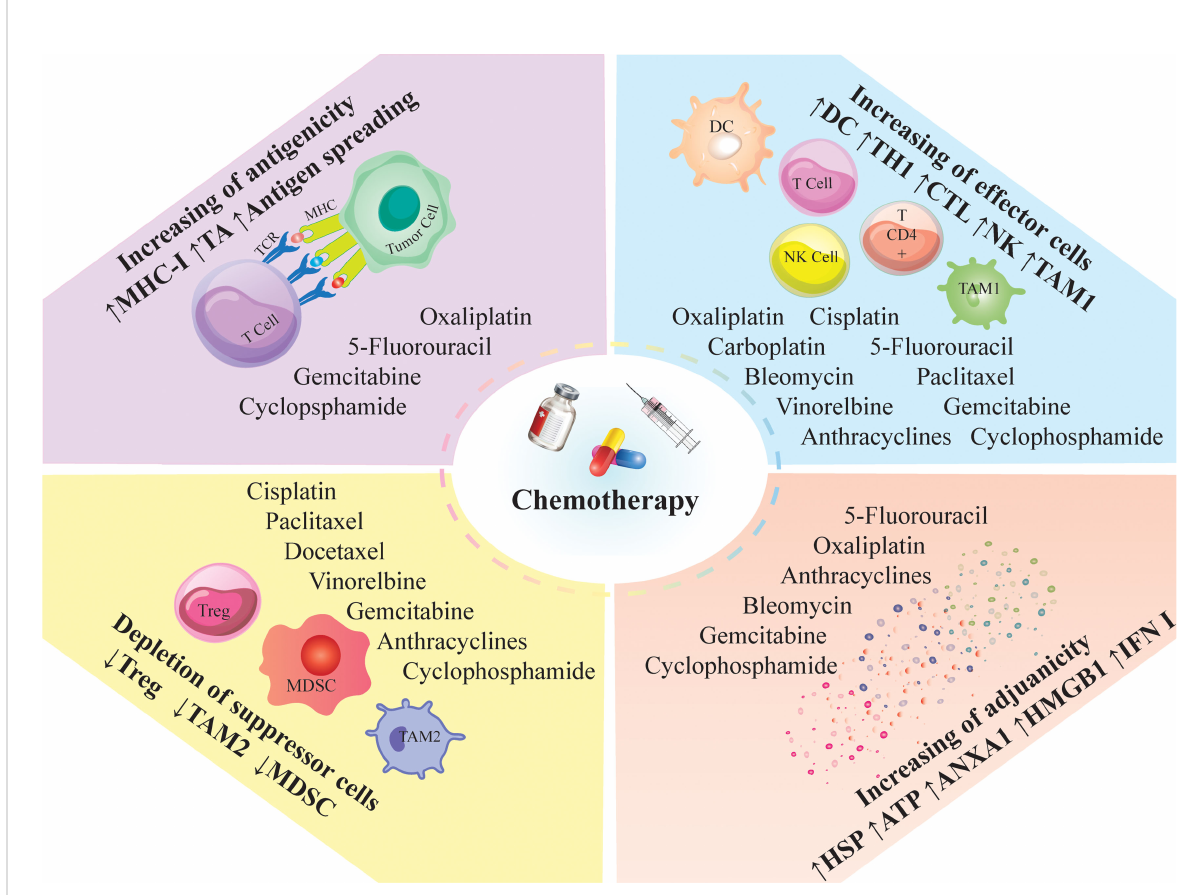
FIGURE 3 Immunomodulatory effects of chemotherapy; Chemotherapeutic agents can modulate the anti-tumor immune responses; They induce immunologic death and trigger the release of tumor antigens and neoantigens via antigen spreading; Besides antigen spreading, they can enhance the release of DAMPs and in fl ammatory mediators; The induced in fl ammation can recruit proin fl ammatory cells into the tumor milieu and decrease the immunosuppressor cells; Such in fl ammatory conditions; ANXA1, annexin A1; CTL, cytotoxic T lymphocyte; DC, dendritic cells; HMGB1, high mobility group box 1; HSP, heat shock protein; IFN, interferon; MDSC, myeloid derived suppressor cell; MHC-I, major histocompatibility complex class I; NK, natural killer; TAM, tumor associated macrophages; TA, tumor antigen; TCR, T cell receptor; Th, T helper cell; Treg, regulatory T-cell; DAMPs; Damage-associated molecular